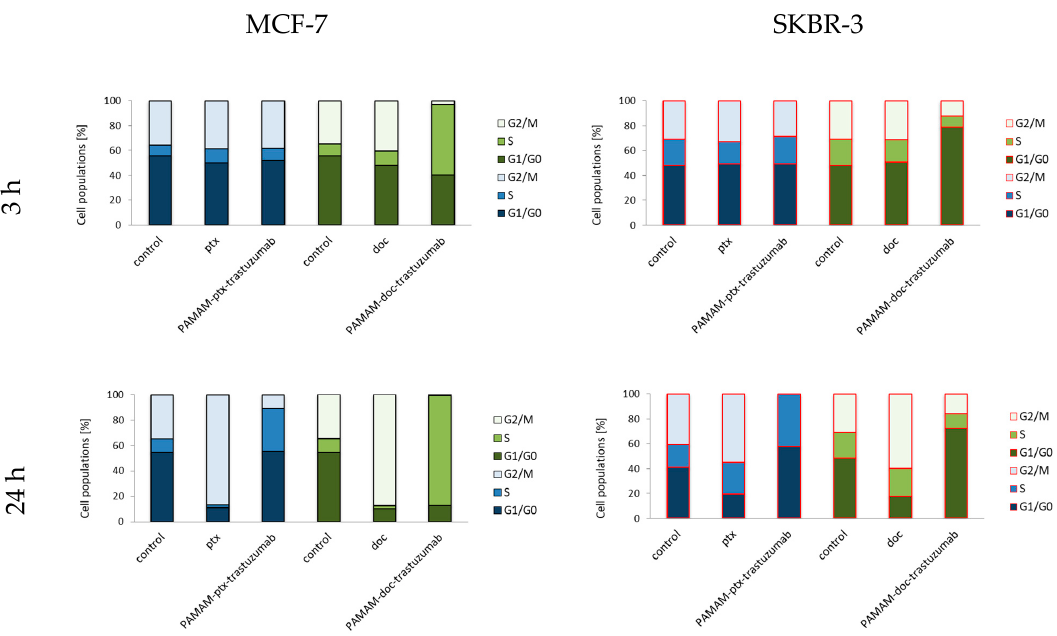
Figure 6. Cell cycle analysis for control (untreated cells) and cells treated with 1 μ M of the PAMAM-ptx-trastuzumab conjugate, PAMAM-doc-trastuzumab conjugate, paclitaxel (ptx) and docetaxel (doc) in MCF-7 cells ( left panel ) and SKBR-3 cells ( right panel ) after 3 and 24 h incubation periods. The results are presented as the mean of three experiments.